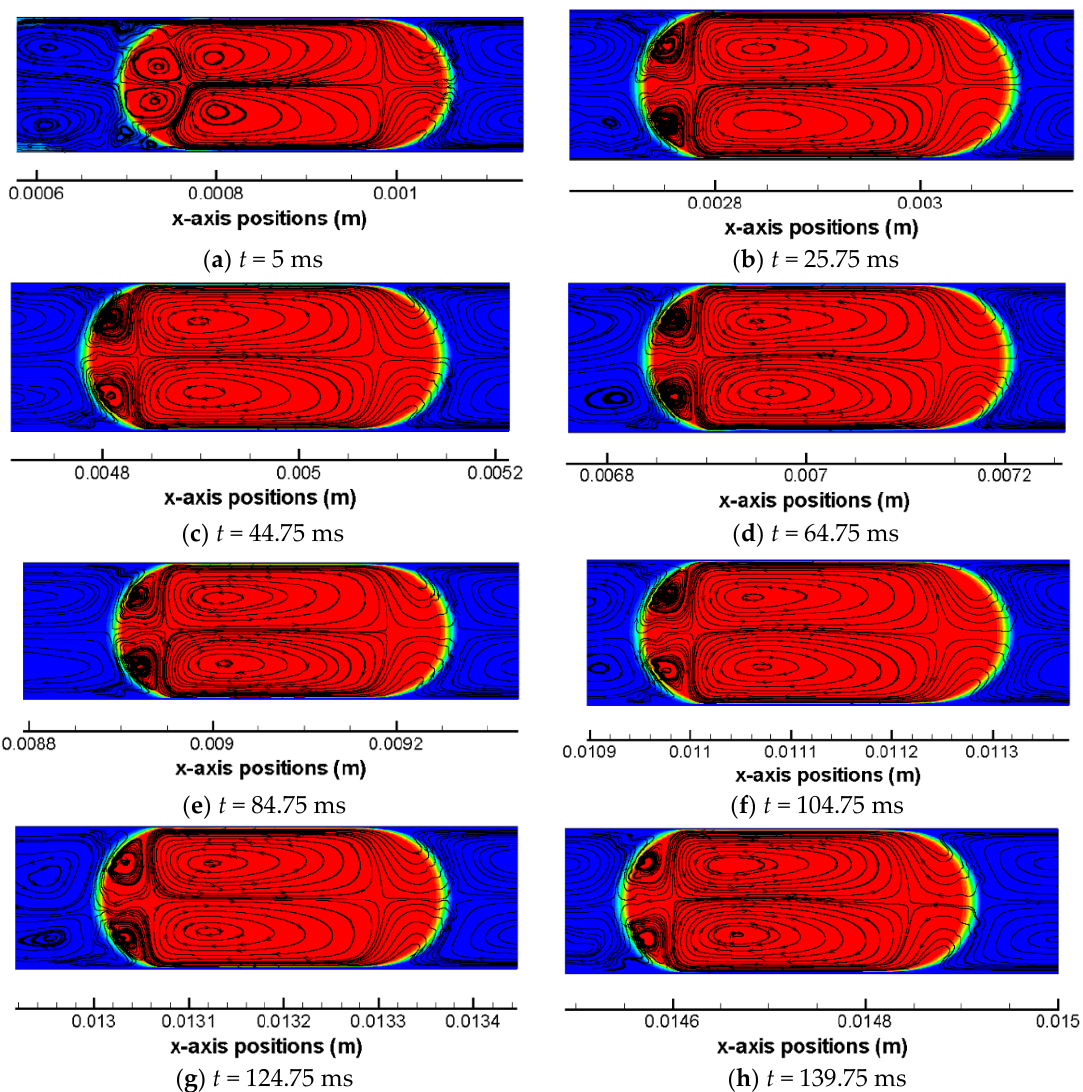
Figure 4. Flow field streamlines within the scCO 2 drop and in the vicinity of the interface in simulation Case 4. The scCO 2 drop is tracked over the drop flowing stage of the computation. Drop profile is presented at eight different time moments ( a – h ). Red color indicates α H2O = 1.